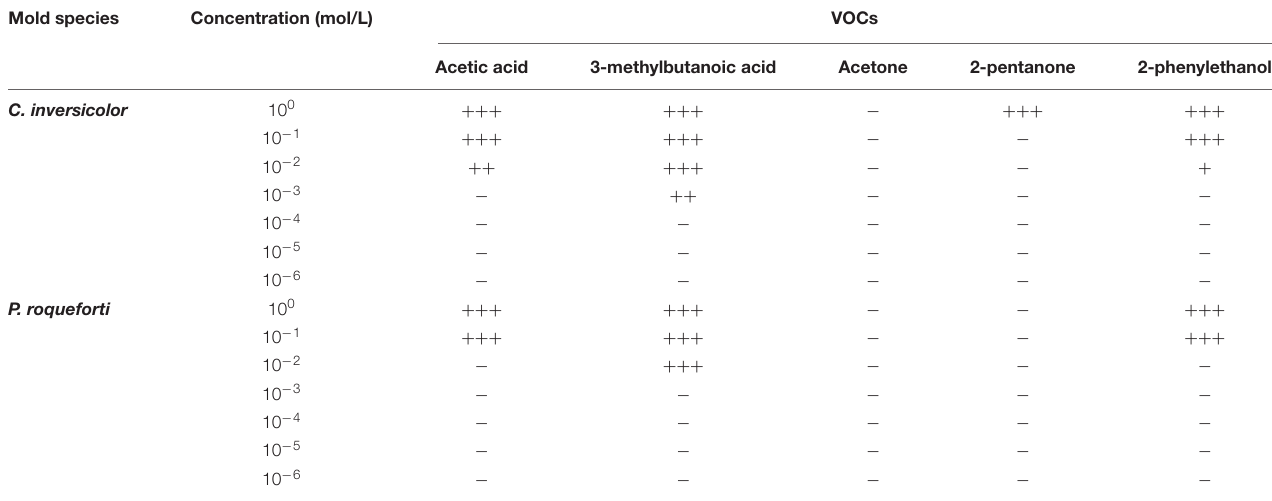
TABLE 6 | Inhibitory effects of five VOCs on the formation of mycelial pellicles of molds after 7 days. Mold